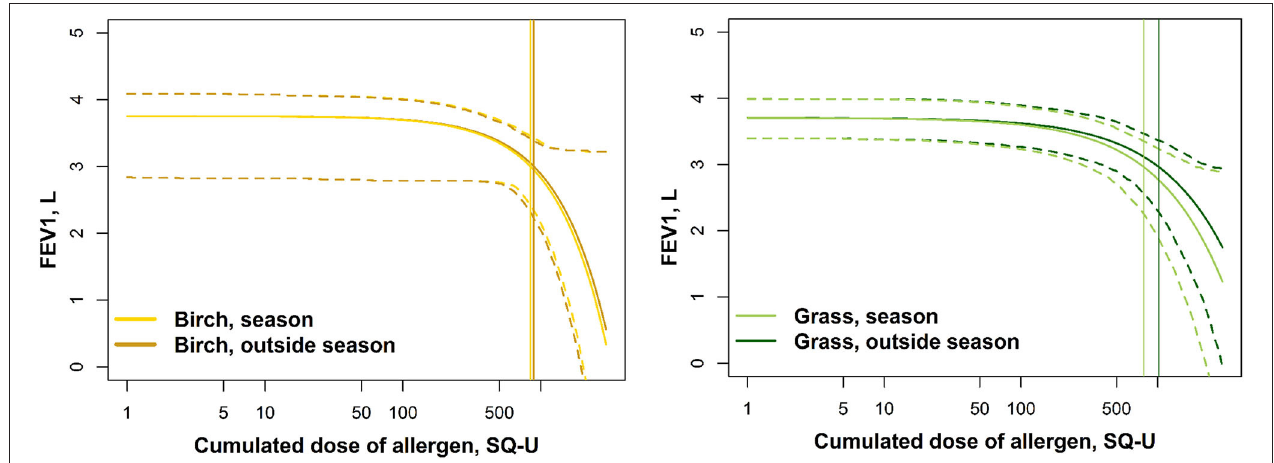
FIGURE 4 | The modeled log-dose-response curves with 95% CI. The vertical lines indicate the modeled PD 20 estimates.